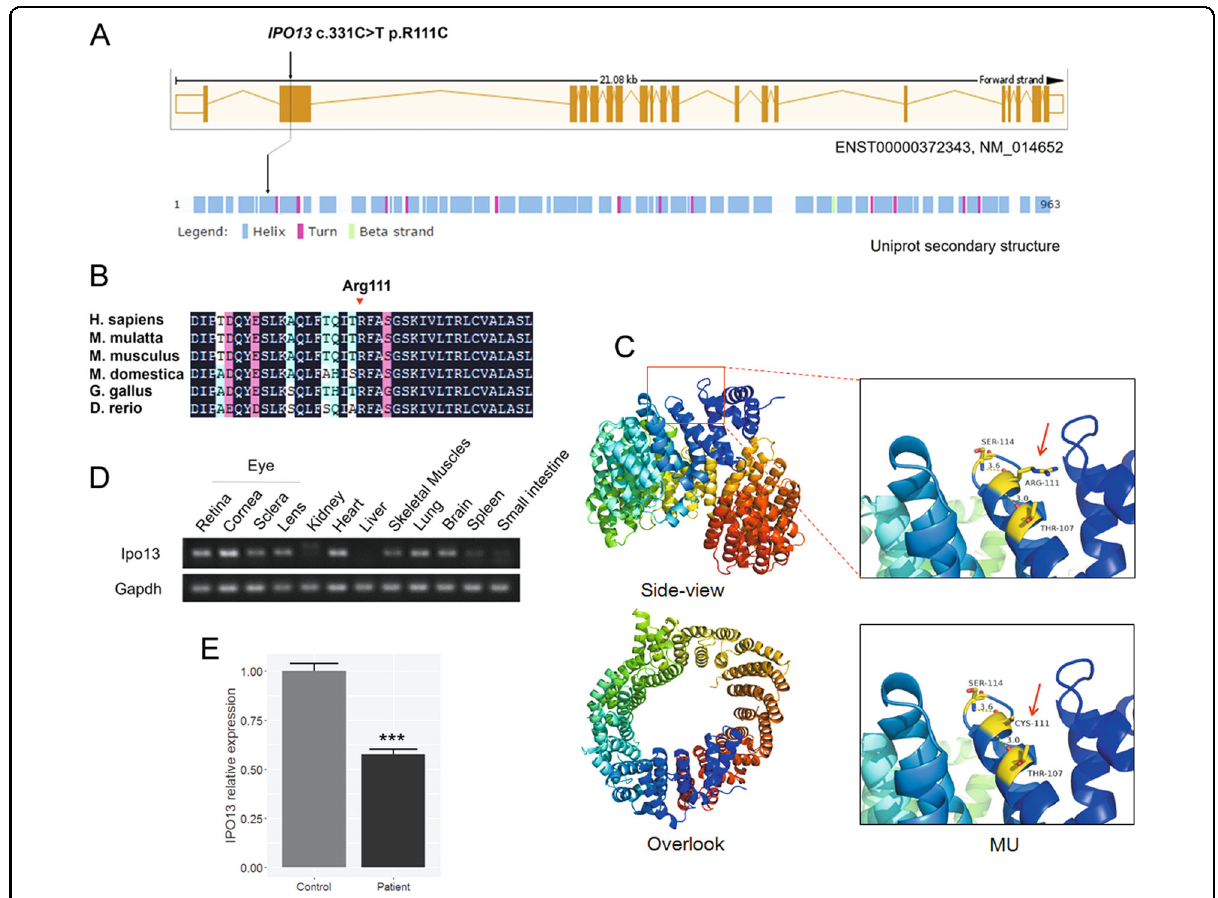
Fig. 2 Mutation location, expression pro fi le of IPO13 , and crystal structure model of IPO13. a Schematic representation of the mutation in IPO13 (ENST00000372343, NM_014652) and functional domains. b Conservation analyses of the mutated residues 111 in IPO13 across different species. c Crystal structure modeling of IPO13 (Phyre2: template c2x19B_). The mutant protein containing R111C (red) shows an increase in the number of hydrogen bonds. d RT-PCR in mouse tissues shows high expression of Ipo13 in the cornea, sclera, lens, and retina. e Comparison of the IPO13 expression in the patient and normal control. The results from real-time quantitative PCR show that the IPO13 mRNA level (normalized to GAPDH) was approximately 43% lower in the patient than in the normal control (*** P <